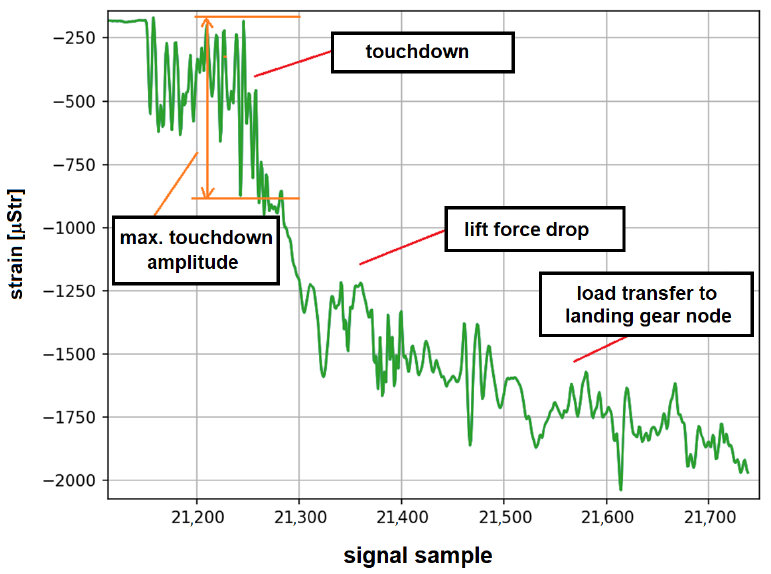
Figure 12. An example of strain record for full stop landing with indication of subsequent stages of this